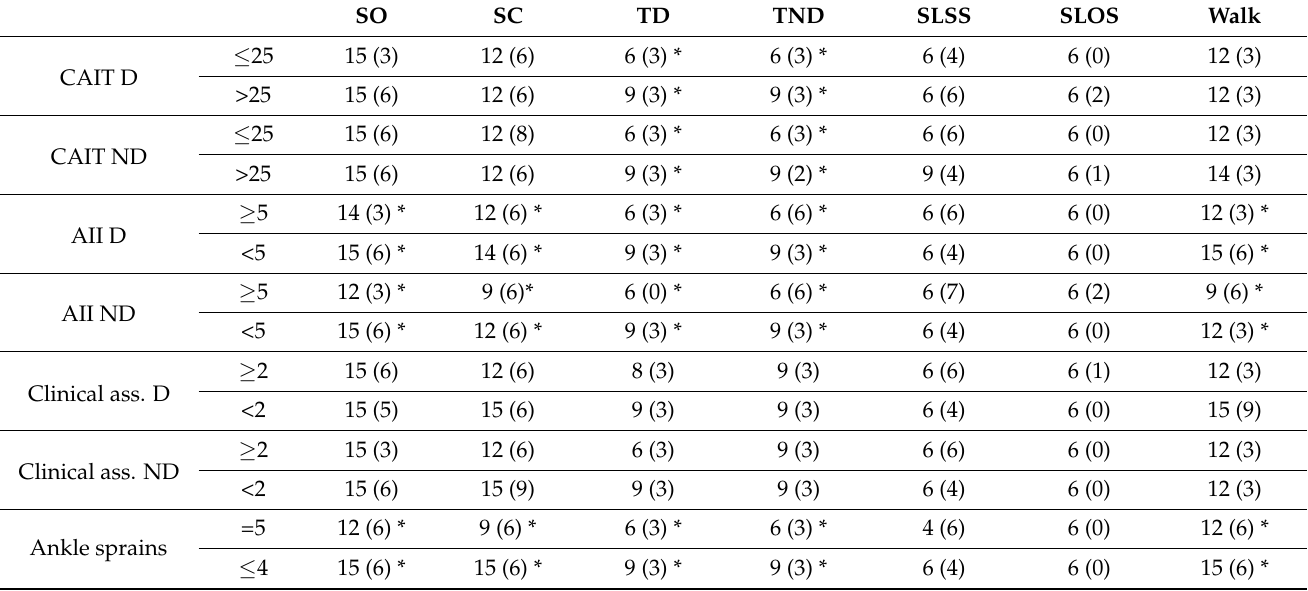
Table 2. Median (IQR) for those with and without ankle instability in each starting position. SO SC TD TND SLSS SLOS